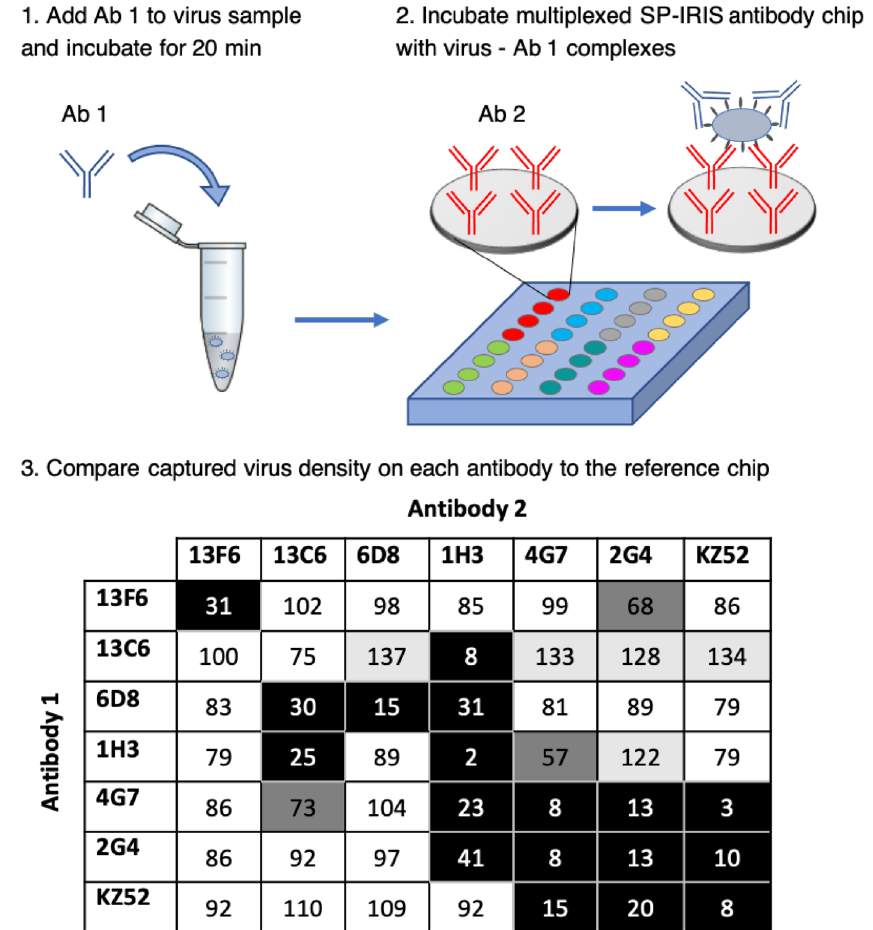
Figure 7. SP-IRIS-based antibody competition assay for anti-EBOV GP antibodies. Top part shows a schematic of the SP-IRIS competition assay. First, antibody 1 (Ab 1) is added to rVSV-EBOV sample in the microcentrifuge tube and incubated for 20 min. Then, this mixture is applied to the SP-IRIS chip spotted with anti-EBOV GP mAbs (Ab 2) and incubated for 1 h. Each mAb is spotted with 4 replicate spots. Following incubation, binding on each mAb is calculated as a percentage of the uncompeted binding from a reference chip that was incubated with the rVSV-EBOV sample alone. Signal on the Ab 2 on the reference chip is taken as 100%. Bottom table summarizes the percent competition binding values. Ab 1 competes with Ab 2 when the percentage is lower than 50% (black boxes). When the percent binding is between 50 and 75%, it is considered intermediate competition (dark gray). Percent binding values between 75 and 110% represent no competition (white boxes), whereas the values over 110% represent an effect that we refer to as binding enhancement (light gray boxes). The results presented in Fig. 7 are representative of two independent competition